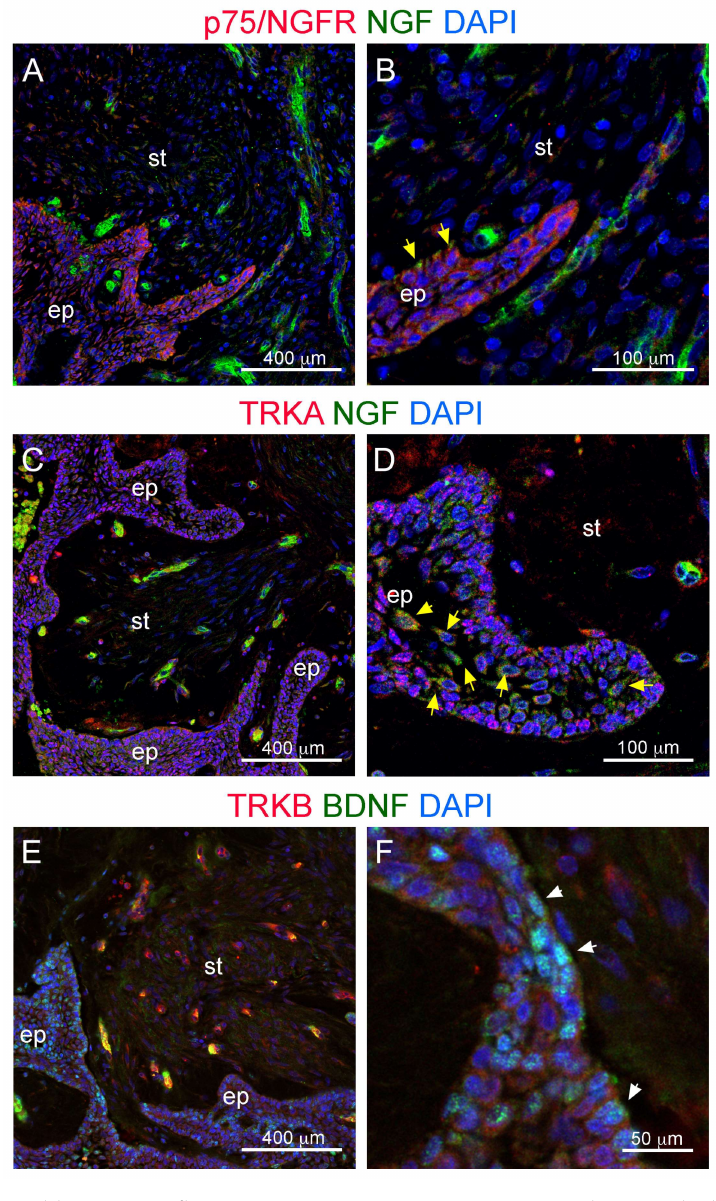
Figure 4. Double immunofluorescent staining against neurotrophins and their receptors. ( A , B ) Immunofluorescent staining against P75 / NGFR (red color) and NGF (green color). ( C , D ) Immunofluorescent staining against TRKA (red color) and NGF (green color). ( E , F ) Immunofluorescent staining against TRKB (red color) and BDNF (green color). Blue color: DAPI. Yellow arrowheads ( B , D ) and white arrowheads ( F ) indicate, respectively, NGF expressing- and BDNF expressing-cells within the ameloblastoma epithelium. Abbreviations: BNDF, Brain Derived Neurotrophic Factor; ep, epithelium; NGF, Nerve Growth Factor; st, stroma. Scale bars: ( A , C , E ): 400 µ m; ( B , D ): 100 µ m; ( F ): 50 µ